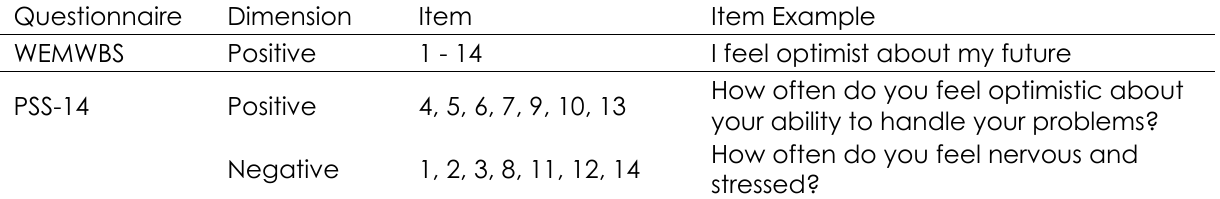
Table 3. The specification of the three measurement tools according to each dimension